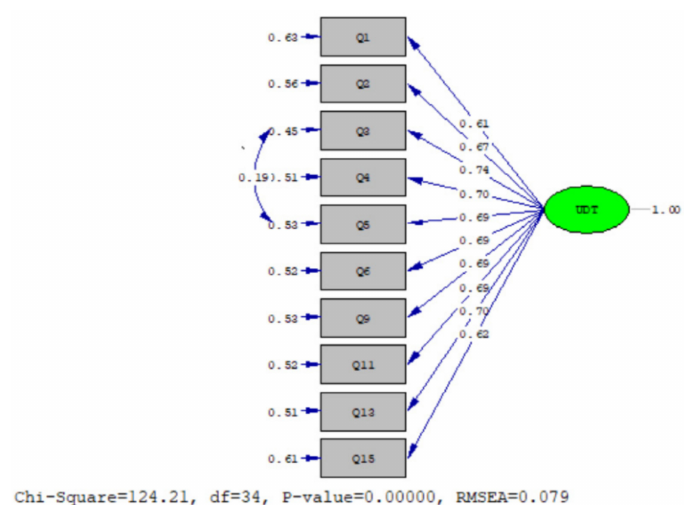
Figure 5. Alternative Model 2.